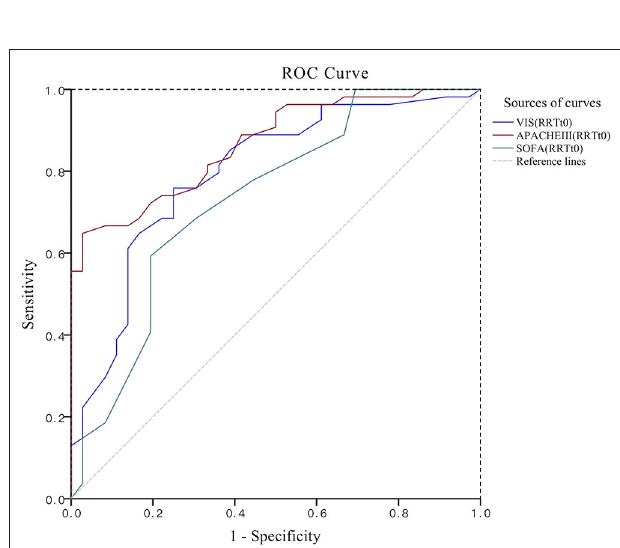
FIGURE 2 | ROC plot for the comparison of three scores. RRT, renal replacement therapy; RRTt 0 , the start of RRT; APACHEIII, acute physiology and health score; SOFA, sequential organ failure assessment; VIS, vasoactive-inotropic score.